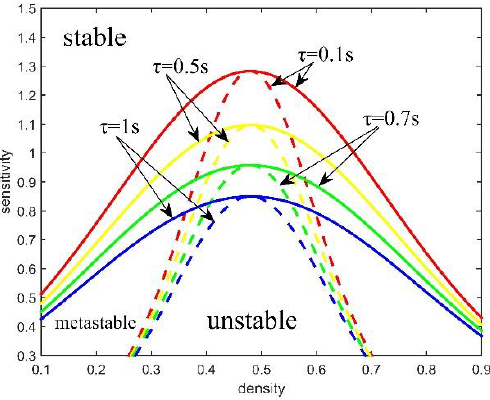
Figure 3. Phase diagrams in the density-sensitivity space for different τ.